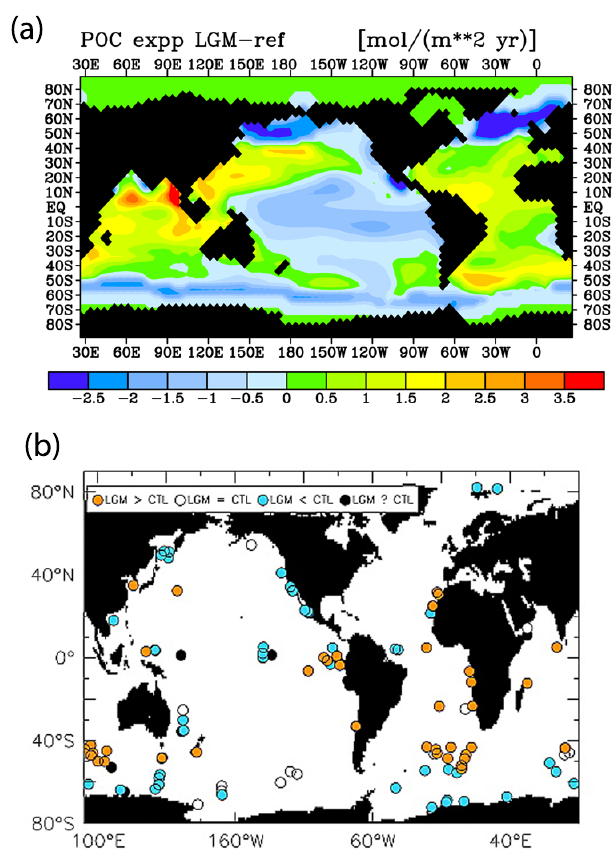
Fig. 4. (a) Change in POC export production in the LGM simu- lation (without shelf input) relative to the reference run (units in molm − 2 yr − 1 ). (b) Export production (EP) for the LGM minus to- day, based on paleodata indicators from Bopp et al. (2003); the top panel shows whether the EP increased (LGM > CTL), decreased (LGM < CTL), remained the same (LGM = CTL) or is undeter- mined (LGM ? CTL) during the LGM compared to today (CTL for